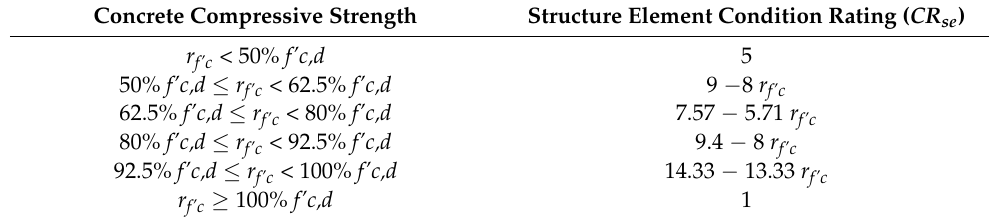
Table 3. Structure element condition